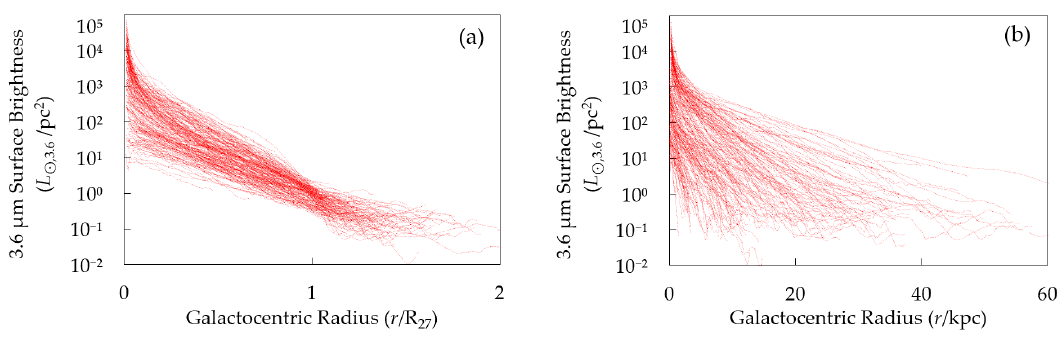
Figure 5. Spitzer 3.6 µ m surface brightness profiles of 214 galaxies: ( a ) Plotted for ease of comparison against radii rescaled as multiples of R 27 , the latter is determined empirically for each galaxy as the radius at which 3.6 µ m apparent surface brightness fades to 27 mag AB / arcsec 2 ; ( b ) plotted against radii in kpc.